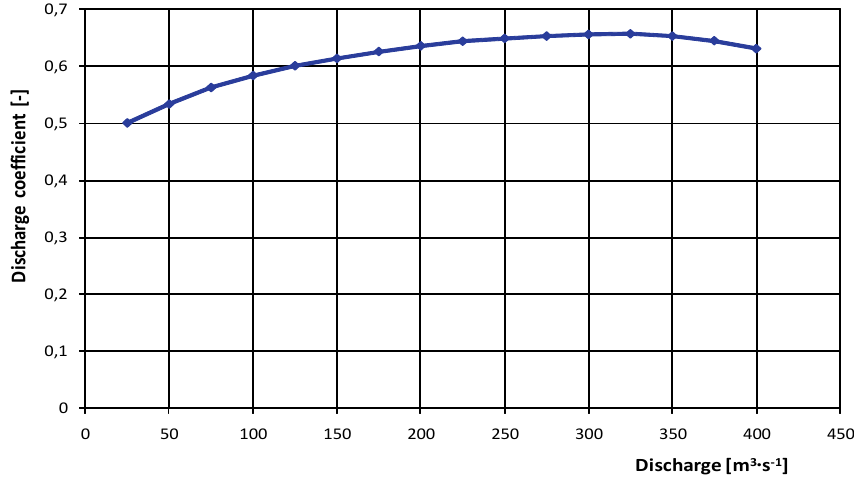
Fig. 8. Changes of discharge coefficients of side channel spillway for the proposed